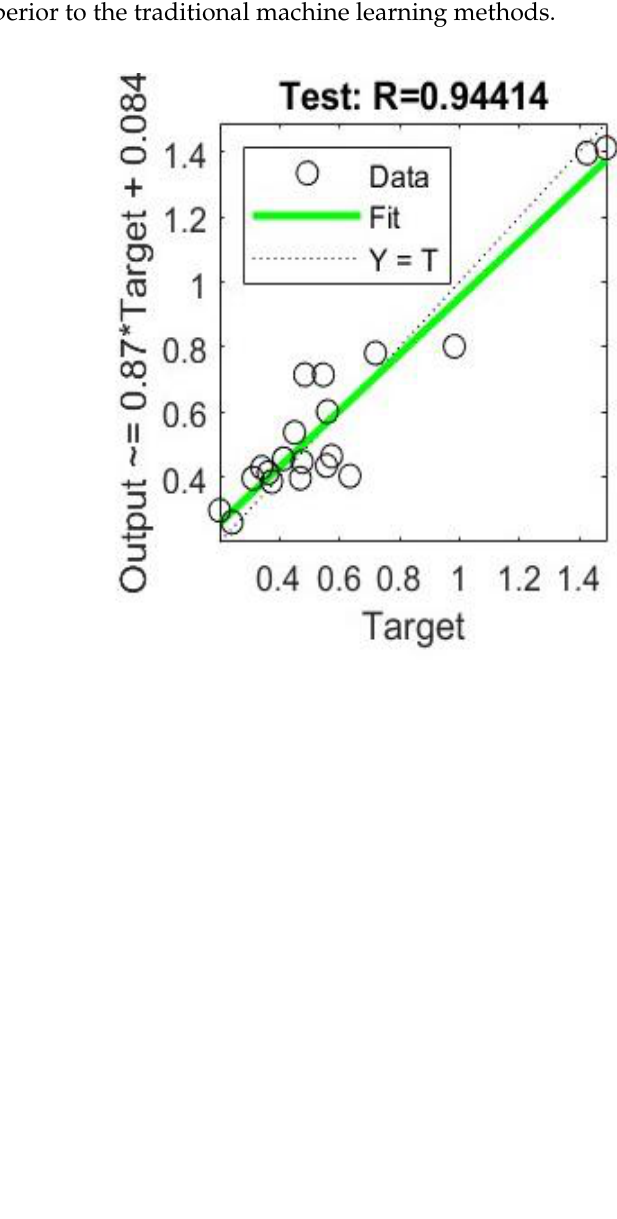
Table 3. Model comparison based on the R, RMSE, and MSE evaluation metrics.